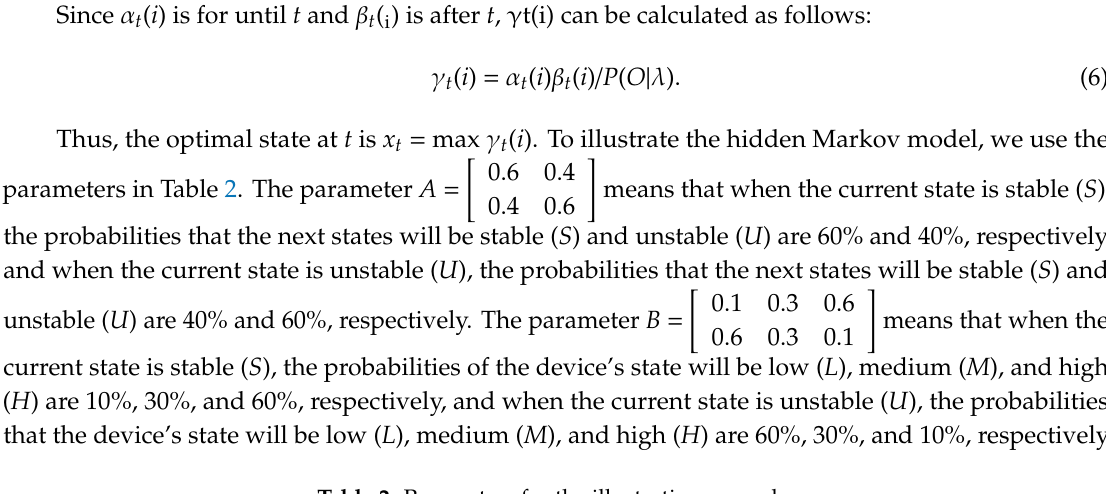
Table 2. Parameters for the illustrative example.